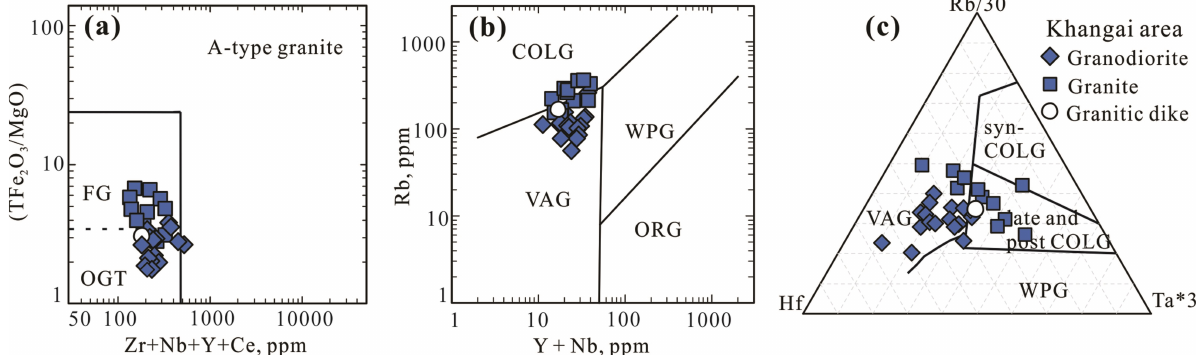
Fig. 9. Diagrams showing granitic rocks from the Khangai area plotted on tectonic discrimination diagrams. (a) TFe O /MgO vs. (Zr + Nb + Y + Ce) after Whalen et al. (1987). (b) Rb vs. (Y + Nb) after Pearce et al. (1984). 2 3 (c) Ternary Hf vs. Rb/30 vs. Ta*3 diagram after Harris et al. (1986). Abbreviations are as in Fig. 6 with OGT = unfractionated granite and FG = fractionated